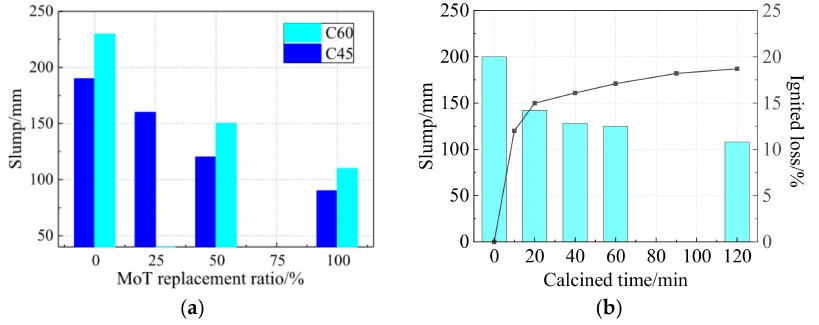
Figure 9. ( a ) Relationship between concrete slump and coal gangue replacement ratio [18]; ( b ) Effect of calcination time on heat loss and flow performance of coal gangue concrete